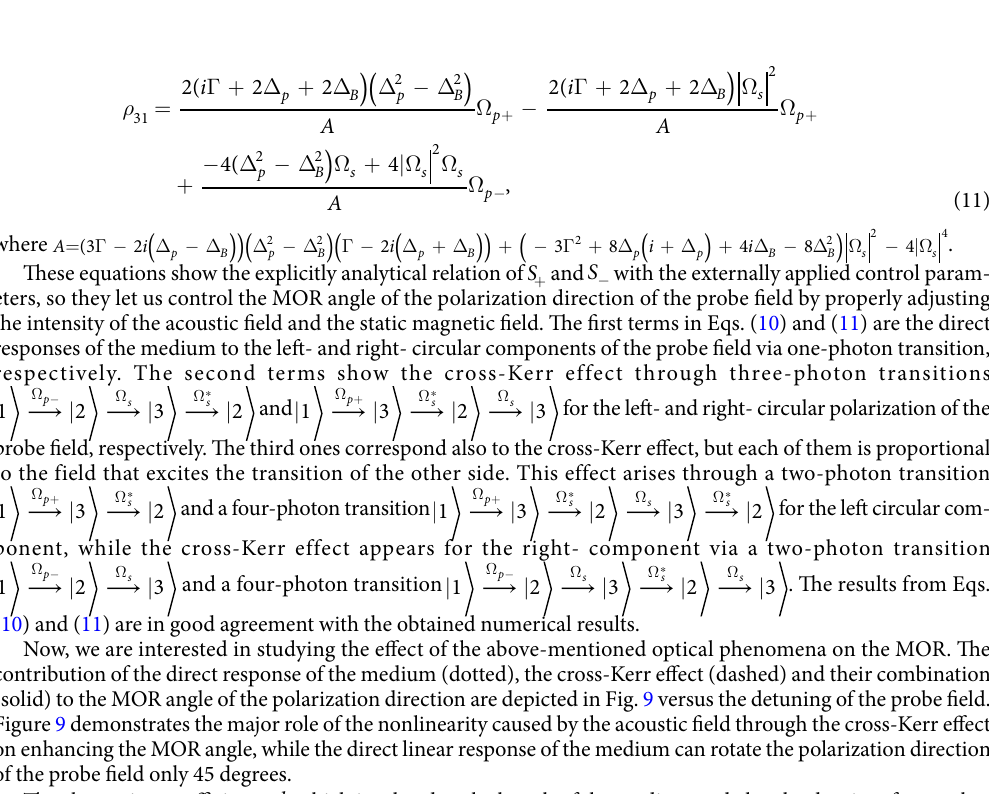
Figure 9. Contribution of the direct response of the medium (dotted) to the probe field, cross-Kerr effect (dashed) and their combination (solid) to the MOR angle versus detuning of the probe field. The taken parameters are those used in Fig.